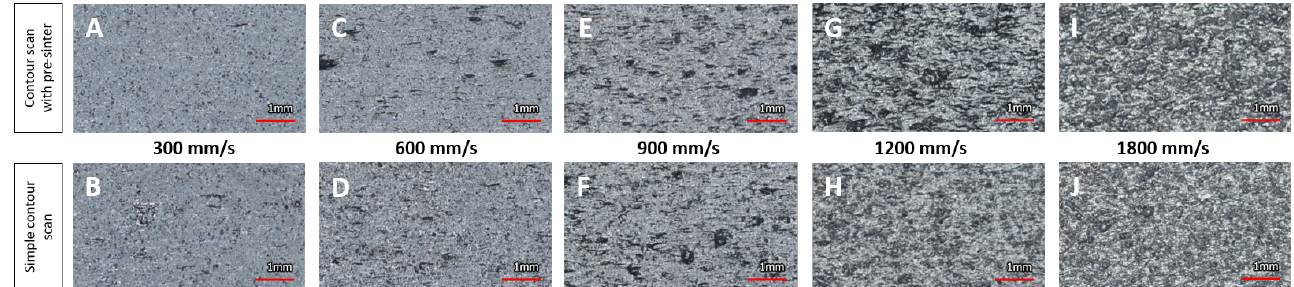
Figure 4. Microscopic images of samples with variation of contour scan speed, from lowest (left) to highest